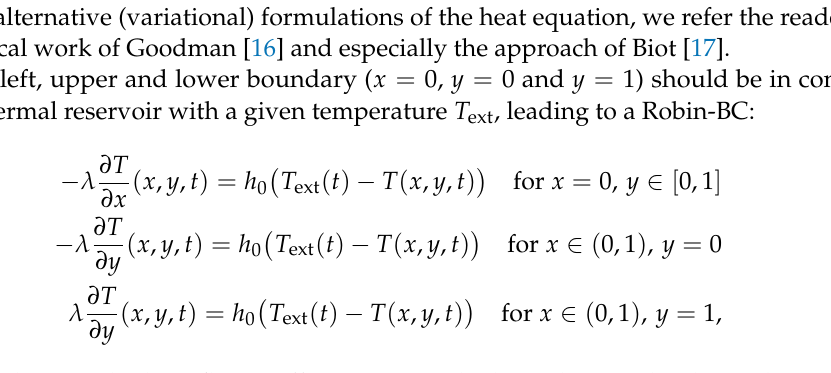
Figure 1. Schematic of the 2D model system with ∂ Ω ext marked as a red line and ∂ Ω c as a blue line.